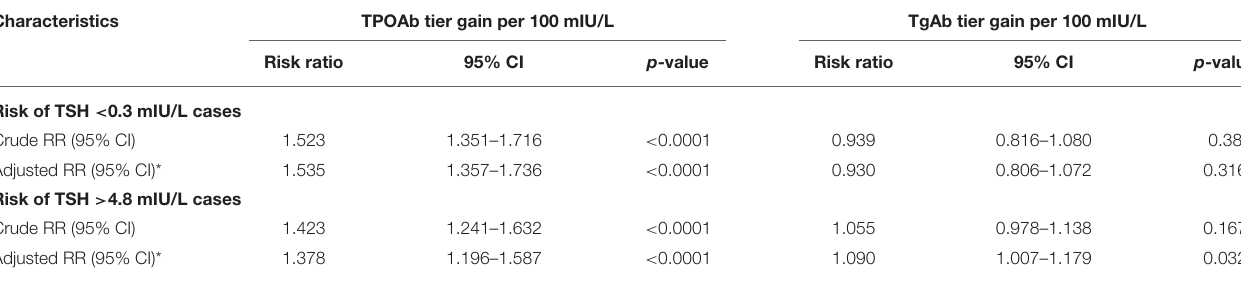
TABLE 3 | Multinomial logistic regression analysis of thyroid antibody tier changes and the risk of abnormal TSH levels.